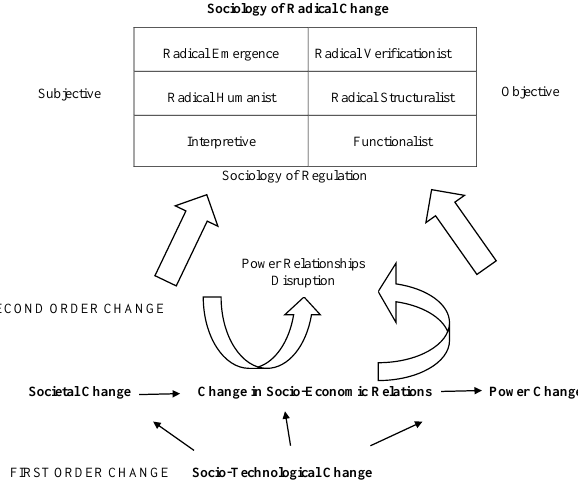
Figure 3: Adapted Paradigm Model located in relation to first- and second-order forces for structural change These effects, however, are expected to have implications for the different assumptions underlying the radical emergence and radical verificationist paradigms. The radical emergence paradigm relates to subjective ontological